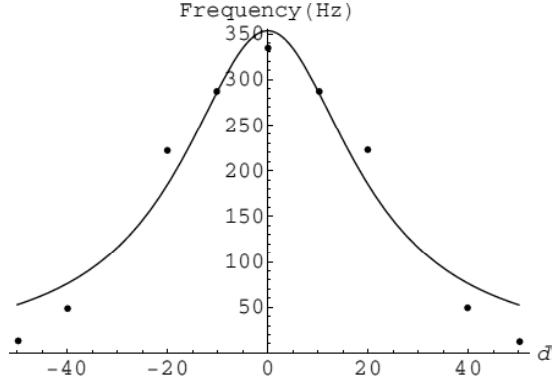
Fig. 11. Pulse repetition rate as a function of  , given by Eq.(50), with the numerical values of  and  given by Eqs.